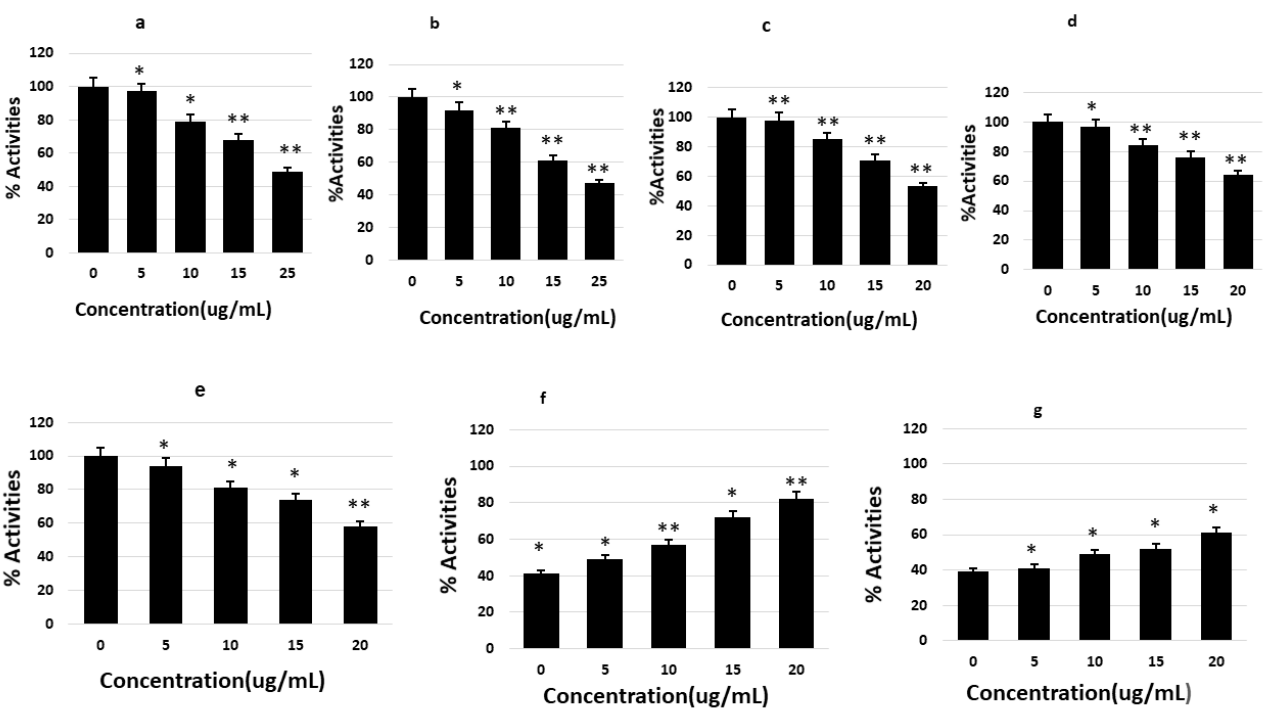
Figure 3. In vitro activities of various kinases and phosphatases involved in tau phosphorylation and dephosphorylation under the effects of theasaponin E1, quantified by ELISA. Percent activity for each enzyme was measured. ( a ) Changes in GSK3beta activity before and after treatment with saponins. ( b ) Changes of CDK5 activity by theasaponin E1. ( c ) Effect of theasaponin E1 on CAMII activity. ( d ) Effect of theasaponin E1 on JNK activity. ( e ) Effects of theasaponin E1 on ERK activities. ( f ) Effects of theasaponin E1 on PP1 activities. ( g ) Effects of theasaponin E1 on PP2B activities. Data are the values of mean ± SEM and were analyzed using one-way ANOVA ( n = 3) (* p < 0.05; ** p < 0.01).